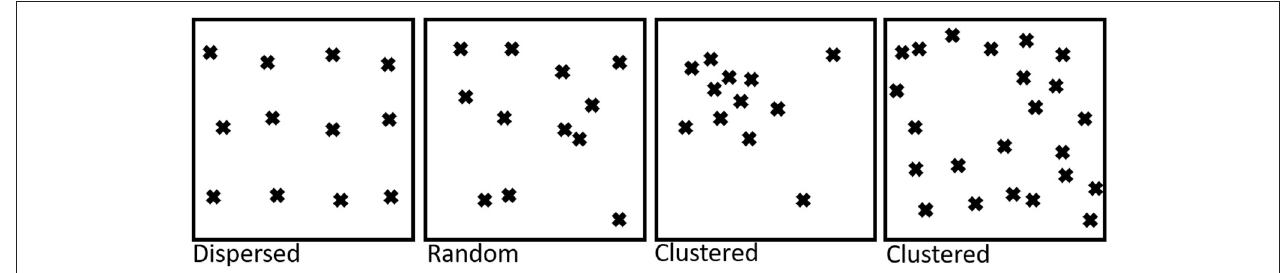
FIGURE 1 | Illustration of different molecule (protein or lipid) distributions on the cell surface. For dispersed distributions, the average distance between molecules is larger than would be expected for randomly distributed molecules. In both the clustered examples shown here, the average nearest neighbor distance is smaller than expected for randomly arranged